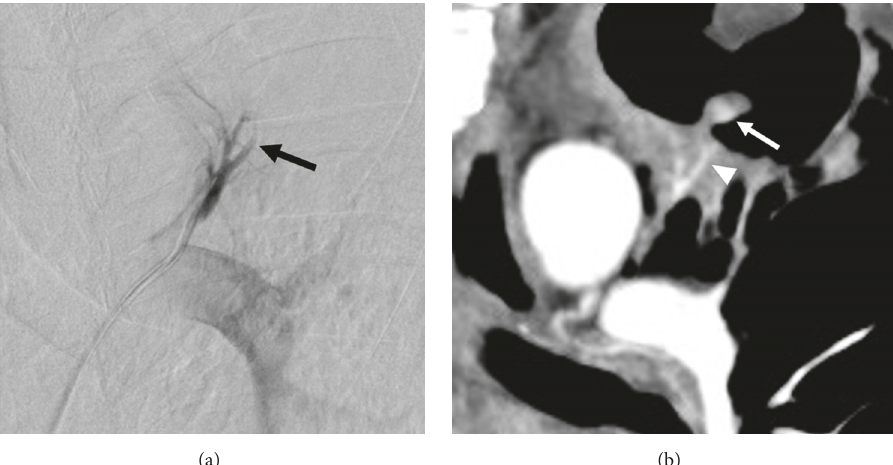
Figure 4: Comparisonbetween pulmonary angiography and computed tomography image. (a) Left segmental pulmonary angiography shows abrupt tapering of the arterial branch (arrow), which indicates retrograde flow from the bronchial to the pulmonary artery. (b) Contrast- enhanced coronal computed tomography image shows the aneurysm (arrow) and the parent artery of the aneurysm (arrowhead). The parent artery corresponds to the abrupt tapering of the arterial branch, which was seen in the left segmental pulmonary